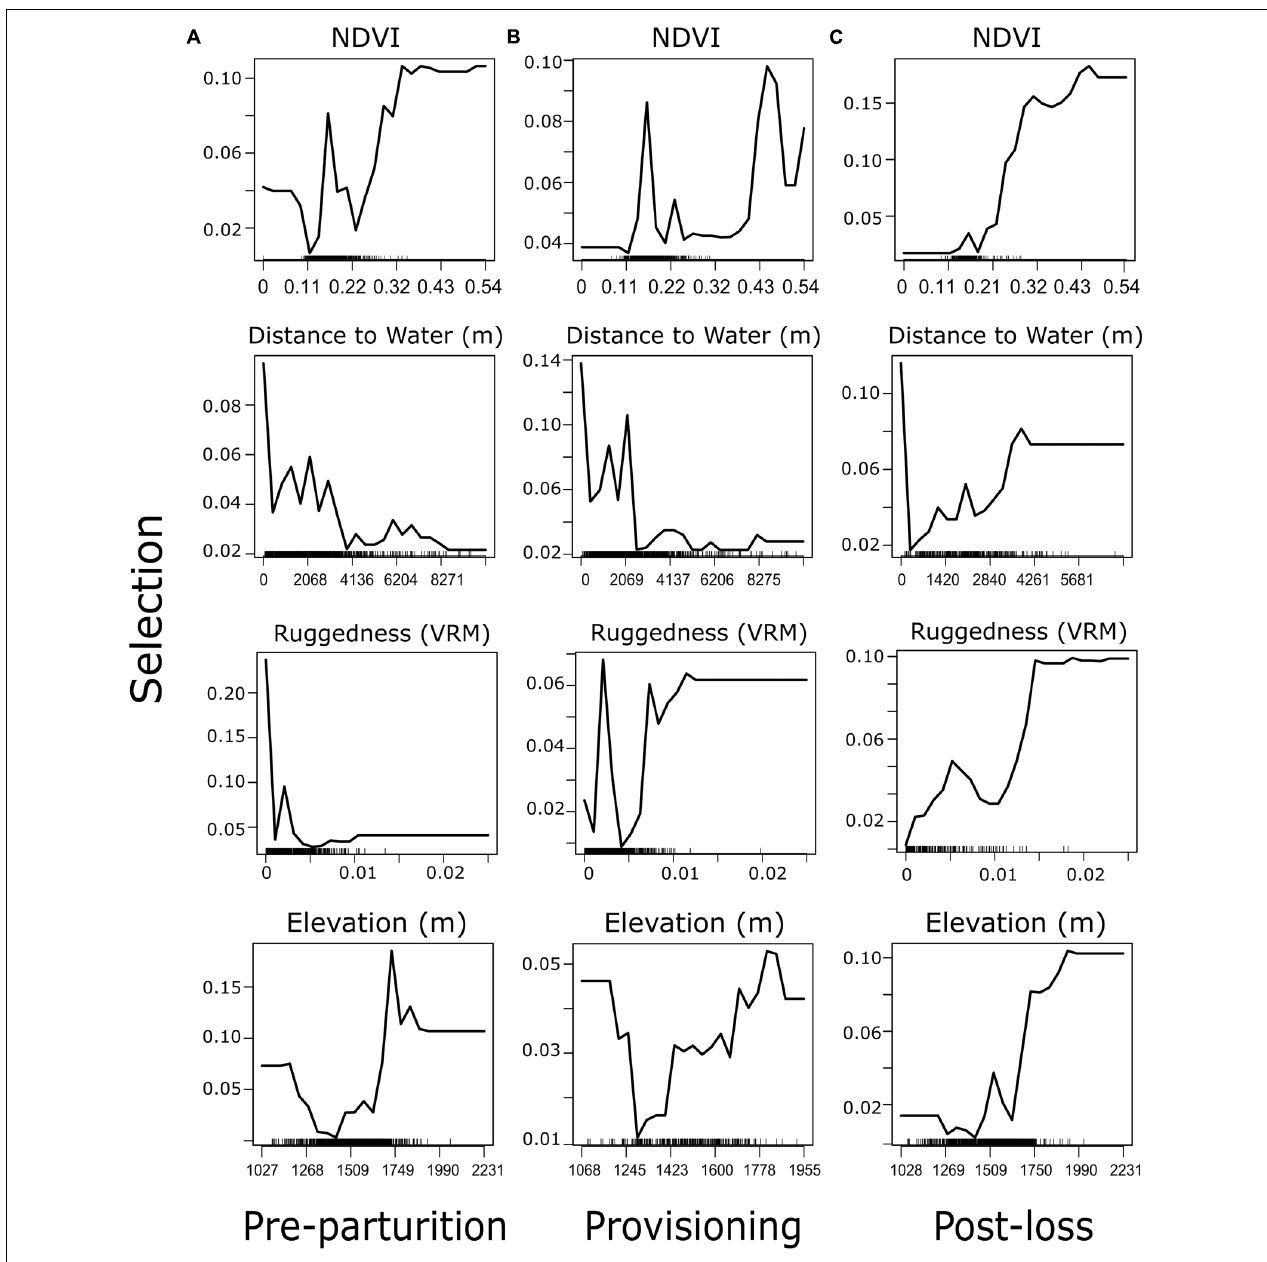
FIGURE 2 | Partial dependence plots of the top four variables explaining resource selection from random forest analysis of female mule deer during (A) pre-parturition ( n = 68), (B) while provisioning offspring ( n = 67), and (C) post-juvenile mortality ( n = 20) on the Mojave National Preserve, California, United States, 2013 – 2016. Selection represents the density of expected occurrences associated with a point on the landscape at the respective value with a point process model (analogous to the probability of being a used location).